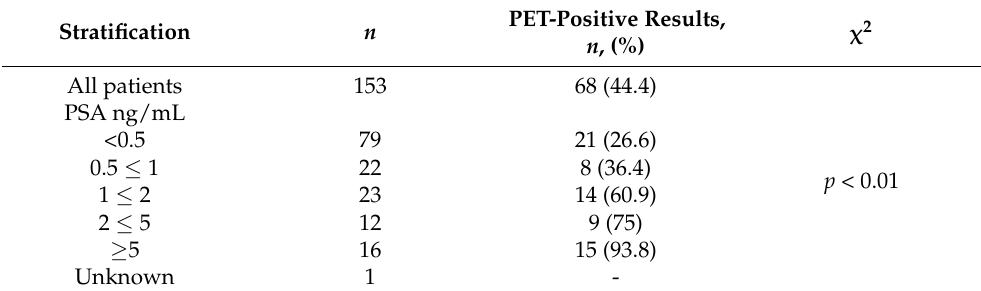
Table 5. 68 Ga-PSMA PET/CT detection rate dependent of PSA at recurrent disease, RP only.